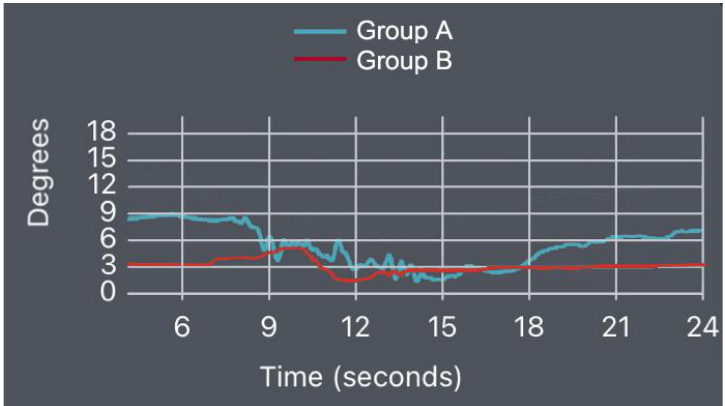
Figure 10. Left-SBT lateral flexion diagram for Groups A and B .